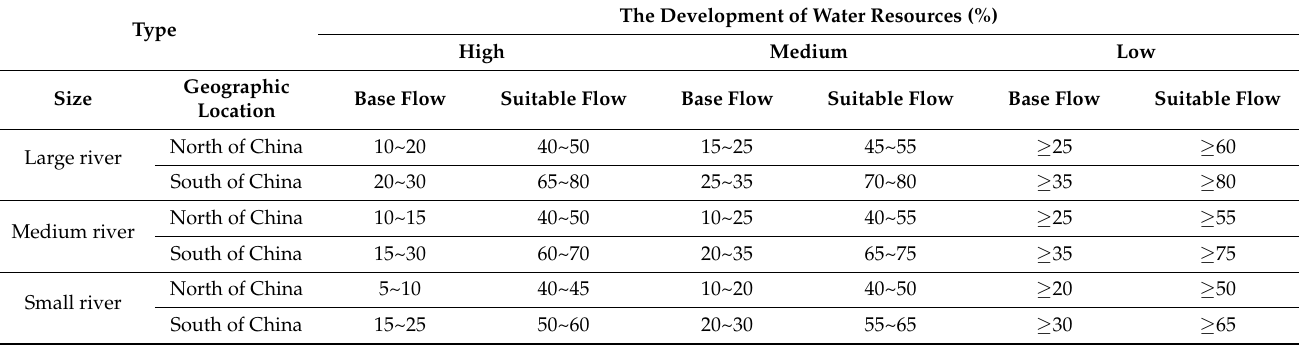
Table 2. Evaluation criterion related to the development of water